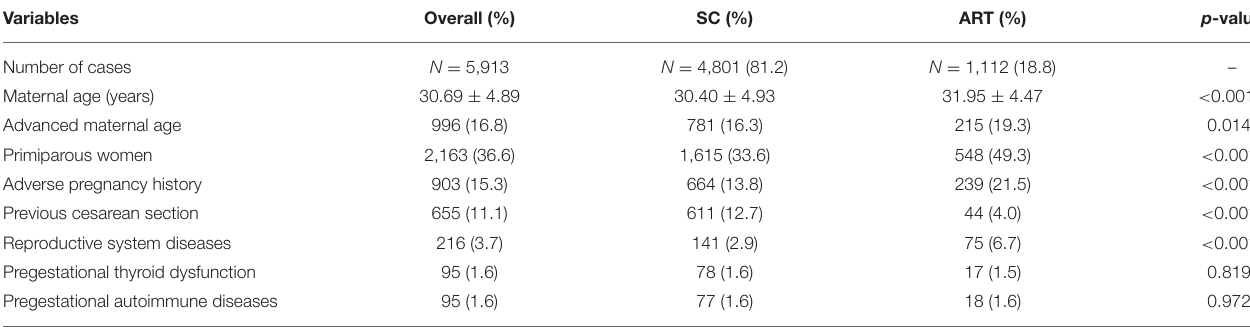
TABLE 1 | Maternal characteristics between the SC and ART groups. Variables Overall (%)